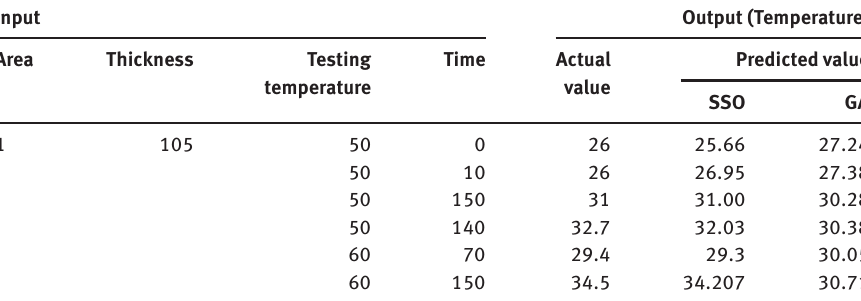
Table 5: Combined Two RCC Wall